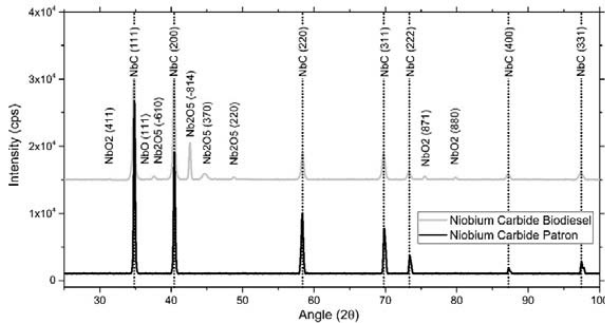
Figure 9. XRD spectrum of the NbC coating before and after exposure to palm biodiesel at 1320 h in OC.